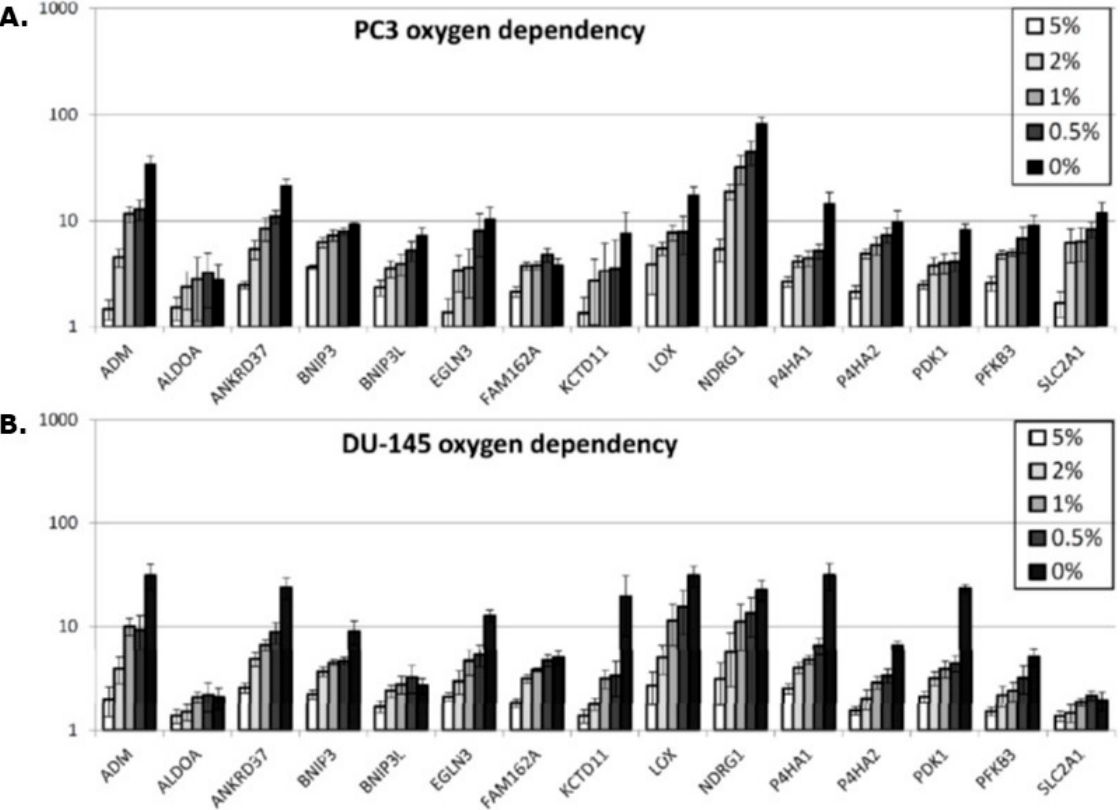
Figure 3. The increased degree of gene expression in vitro under different oxygen concentrations compared to that found under 21% oxygen. Results show means ( ± 1 S.E.) for n = 3 measurements in PC3 ( A ) or DU-145 ( B ) cells. Cells were exposed to the different oxygen concentrations as indicated for 24 h. A greater degree of up-regulation with decreasing oxygen concentration is seen for almost every gene in both cell lines.